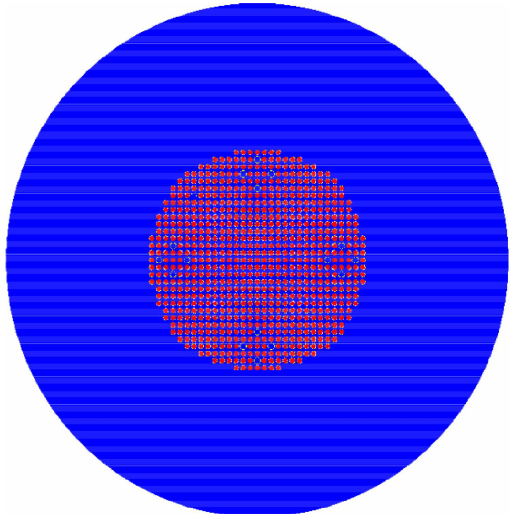
Fig. 4. Radial cross section of the MISTRAL-1 core composed of 750 UOX fuel pins in light water.